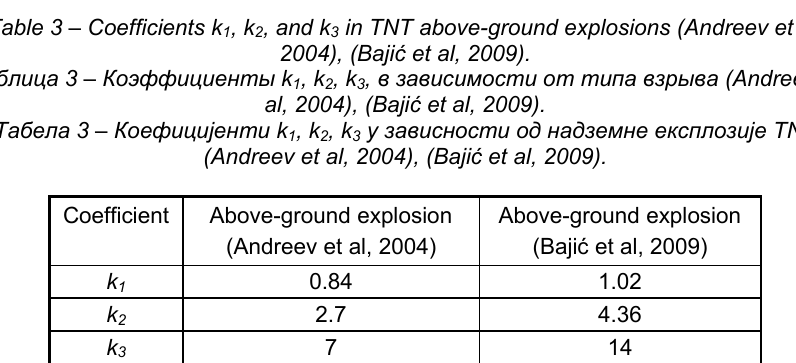
Table 3 – Coefficients k 1 , k 2 , and k 3 in TNT above-ground explosions (Andreev et al, 2004), (Baji ć et al,